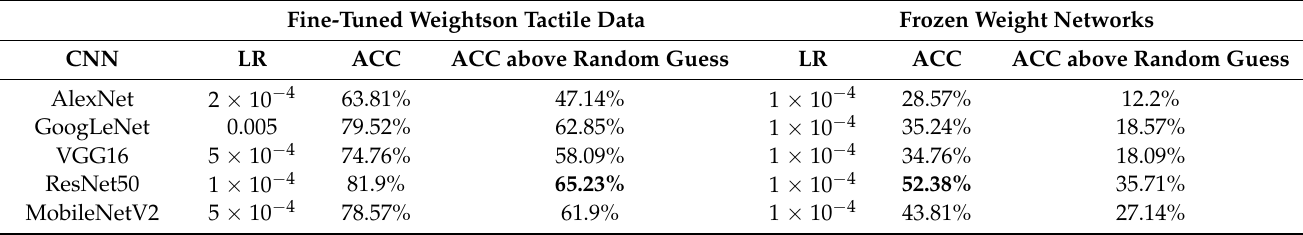
Table 4. Classification results for simulated 128 by 128 FSR tactile data. All networks are trained on a minimum batch of size 16 and for 10 epochs.